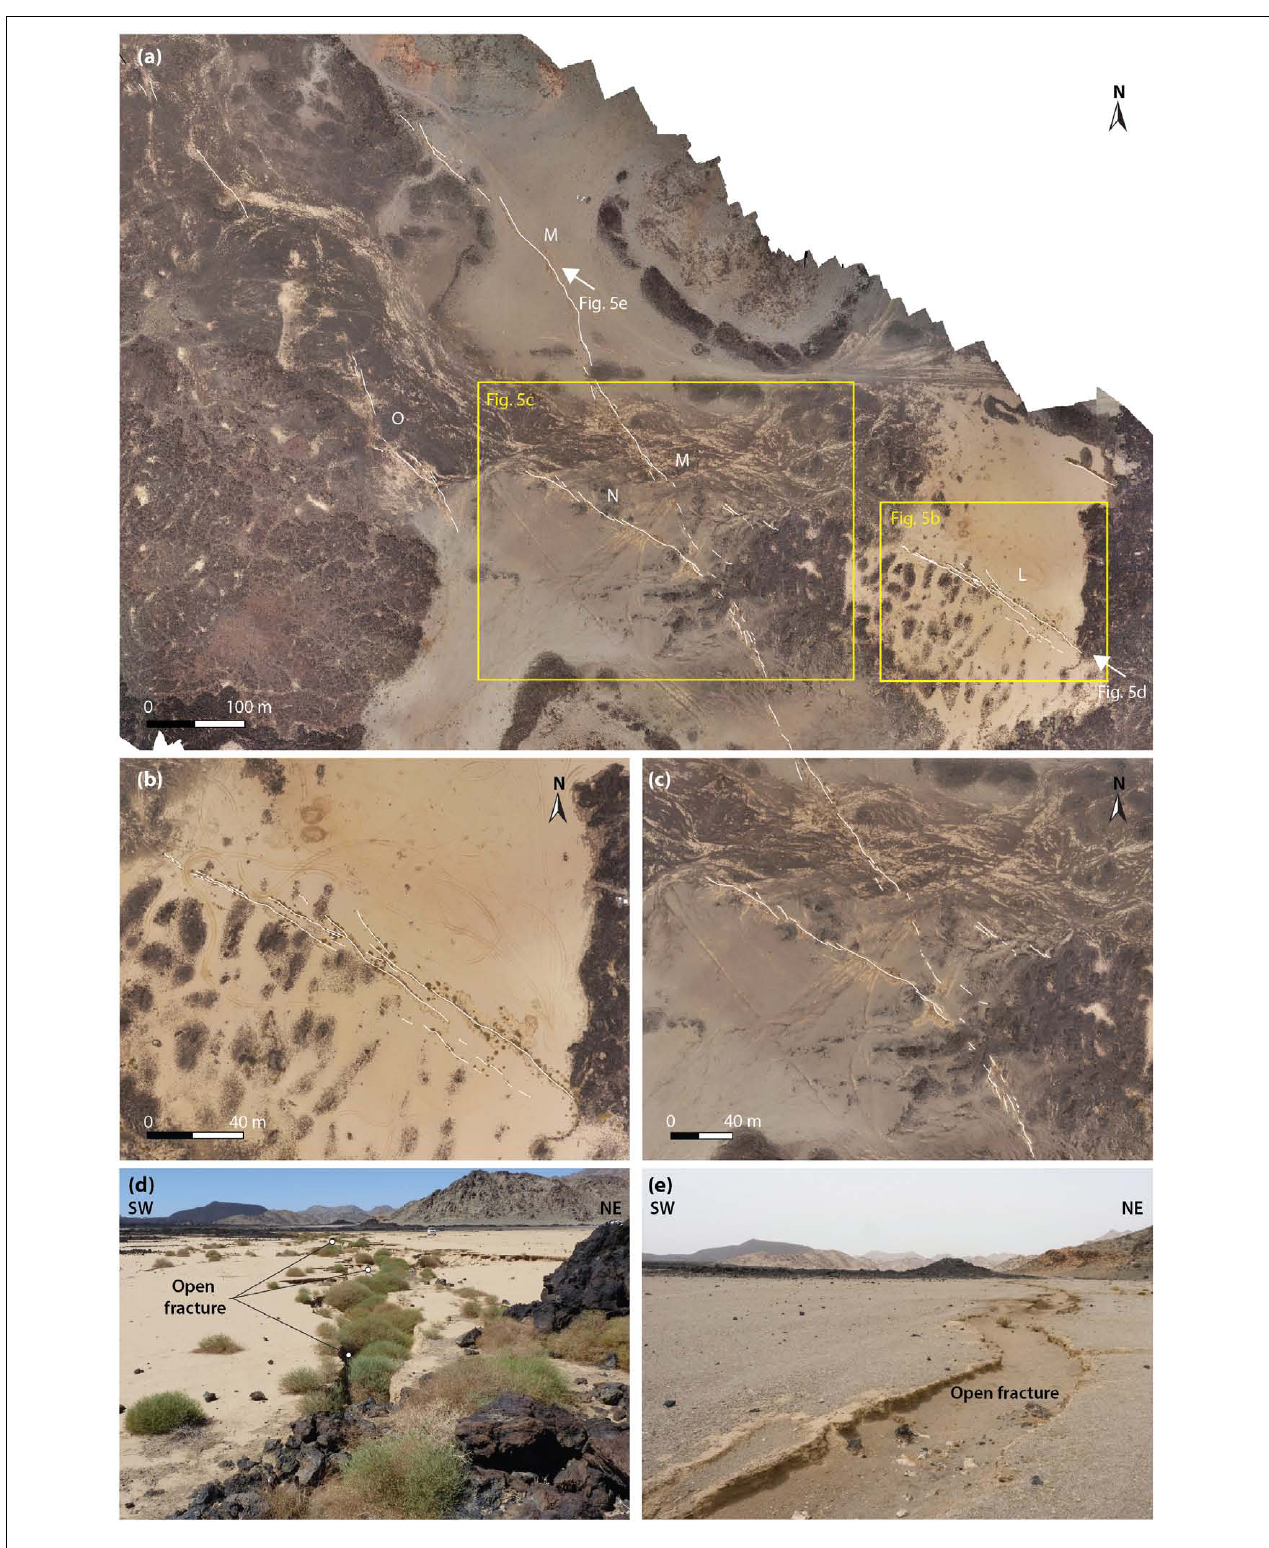
FIGURE 5 | Fracture patterns in the eastern fracture zone. (a) Overview of the eastern fracture zone showing mapped fractures (white lines) along segments L-O (area coverage shown in Figure 2 ). (b) Close-ups of segment L and (c) segments M and N. (d,e) Field photos of open fractures. The photo locations and azimuths indicated by white arrows in (a)